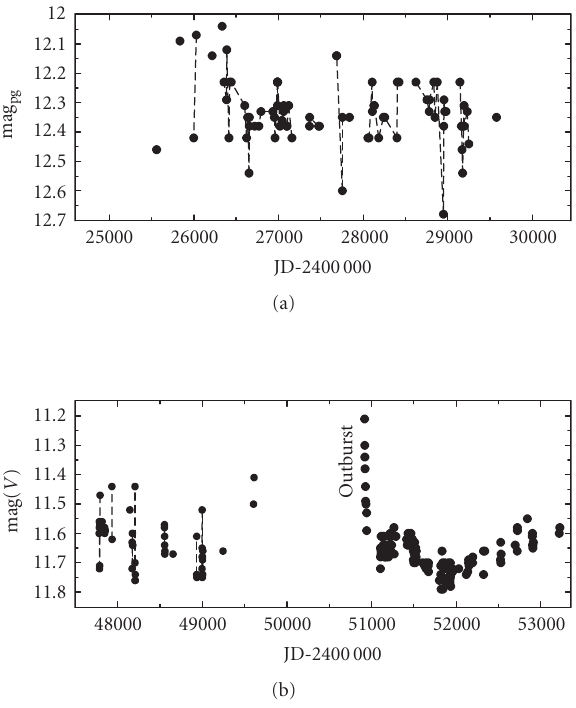
Figure 8: (a) Photometric history of the microquasar CI Cam according to the Bamberg photographic observations in the blue band (similar to the B band) (1928–1939). Points are connected by a line in the densely covered segments. Typical uncertainty is 0.05 mag. (b) The activity in the V passband in 1989–2004. The peak of the 1998 outburst is out of the scale. Adapted from [58,